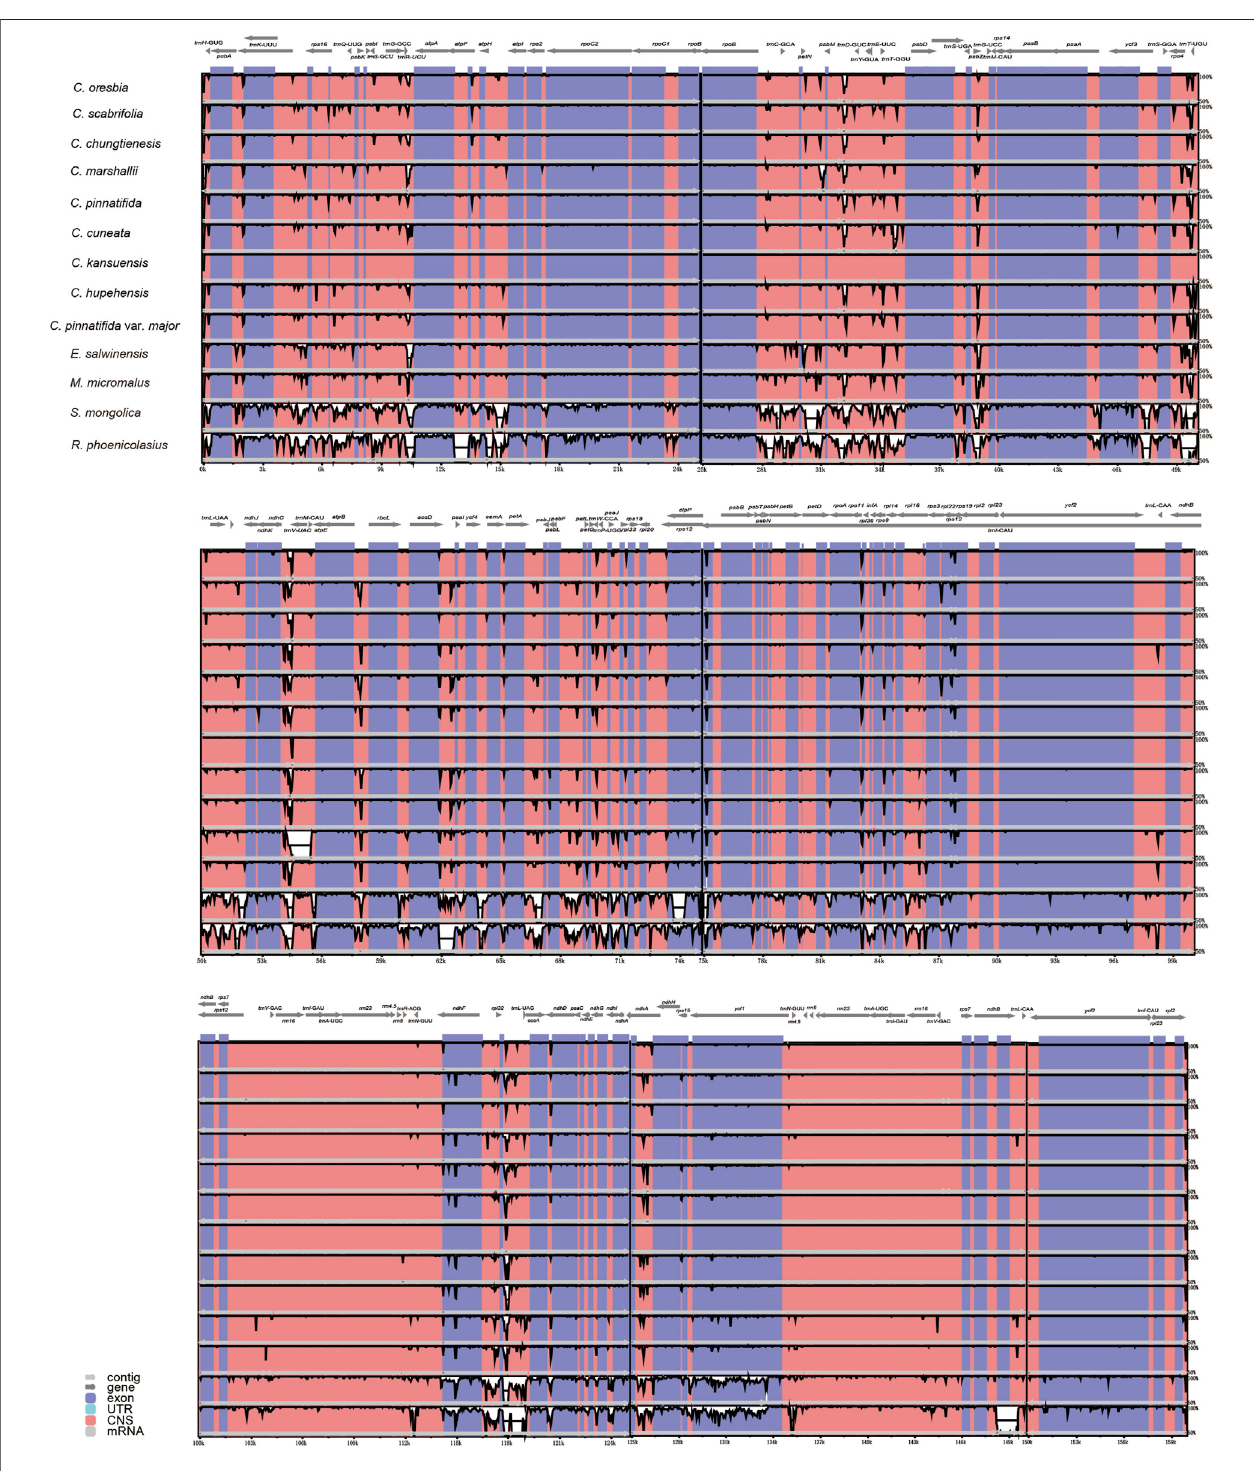
FIGURE3| Completechloroplast genomecomparison of13speciesofRosaceae.Grayarrows indicate thedirectionofthegene.Thedark blueregionsrepresent exons. Pink regions represent noncoding sequences (CNS), and white peaks represent genomic differences. The Y-axis represents the percentage, from 50 to 100%.